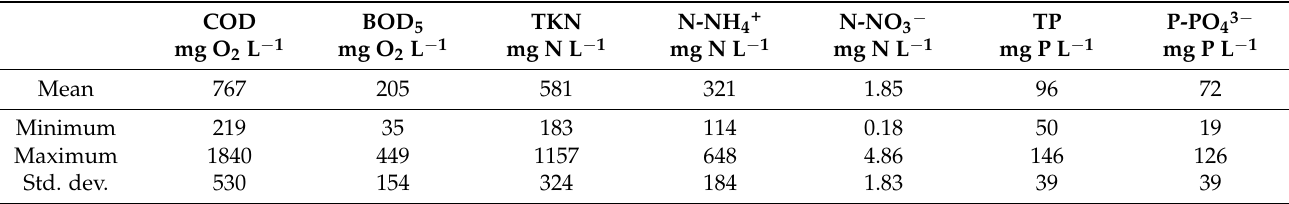
Table 2. The characteristics of rejected water from ATAD process (n = 8), WWTP